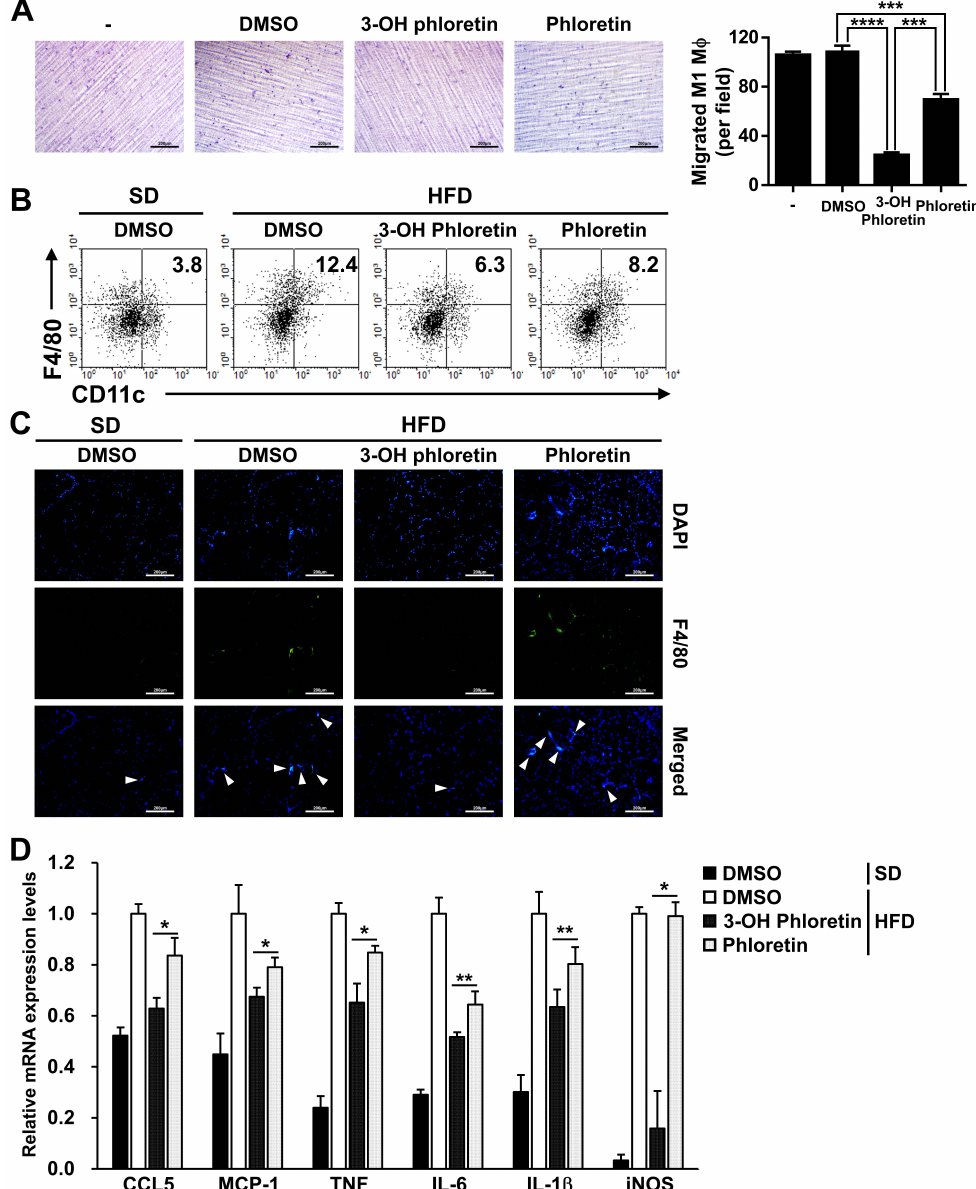
Figure 3. 3-OH phloretin more strongly prevented M1 macrophage infiltration into GWAT by downregulating chemokine expression than phloretin. ( A ) The migration of M1 macrophages to mature adipocytes was determined by the in vitro transwell migration assay. Mature adipocytes were seeded in a 12-well culture plate and stimulated with TNF and IL-6 for 24 h. After washing twice with PBS, the adipocytes were treated with 3-OH phloretin or phloretin, and M1 macrophages were plated in the upper chamber, followed by incubation for 48 h. The migrated M1 macrophages were stained with hematoxylin and examined under a light microscope at 100 × magnification. Scale Bar: 200 µ m. ( B ) The isolated GWAT cells were stained with the indicated fluorescence-conjugated antibodies and analyzed using flow cytometry. ( C ) The F4/80-positive cells were analyzed in the GWAT using immunofluorescence analysis and examined under a fluorescence microscope at × 100 magnification. The F4/80-positive cells are indicated as white arrows, and the nuclei are visible in blue. Scale Bar: 200 µ m. ( D ) mRNA expression levels of chemokines and pro-inflammatory genes were evaluated in the GWAT using real-time PCR. Data are shown as the mean ± SEM from eight independent experiments with similar results, and the error bars represent the mean ± SEM (* p < 0.05, ** p < 0.01, *** p < 0.001, **** p <